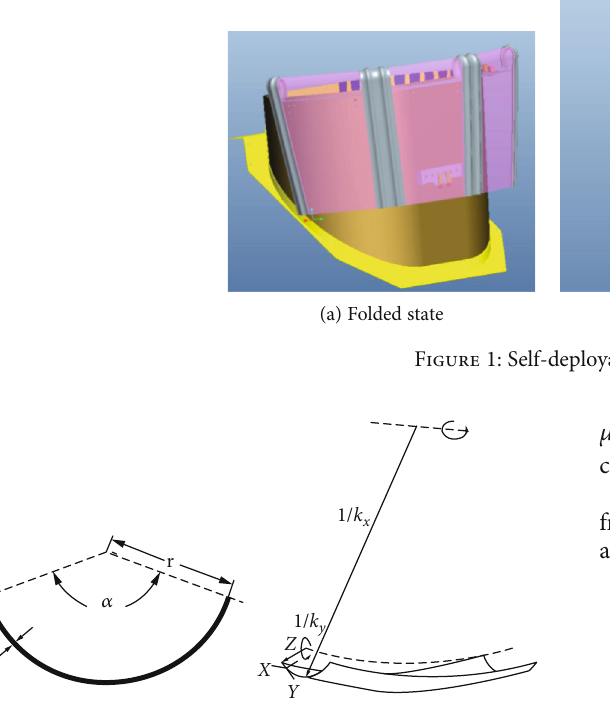
Figure 2: The section and the curvatures of beryllium bronze